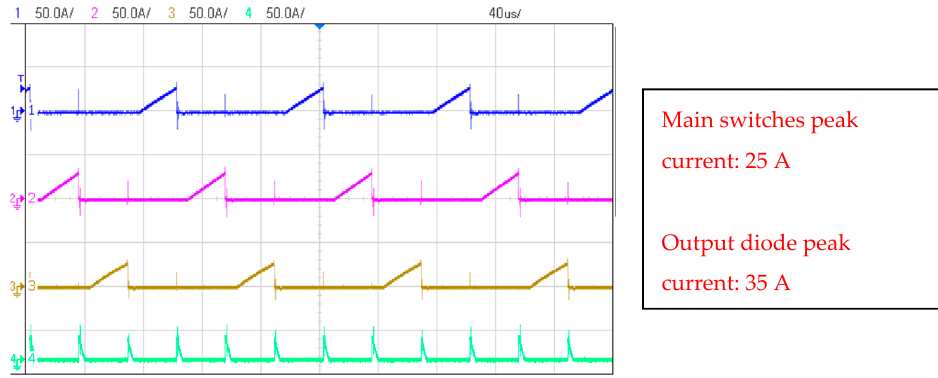
Figure 21. Experimental waveforms. Current: main switch 1 (yellow), main switch 2 (pink), and main switch 3 (yellow); scale 50 A/div. Output diode current (green); scale: 100 A/div. Base time 40 µs/div.